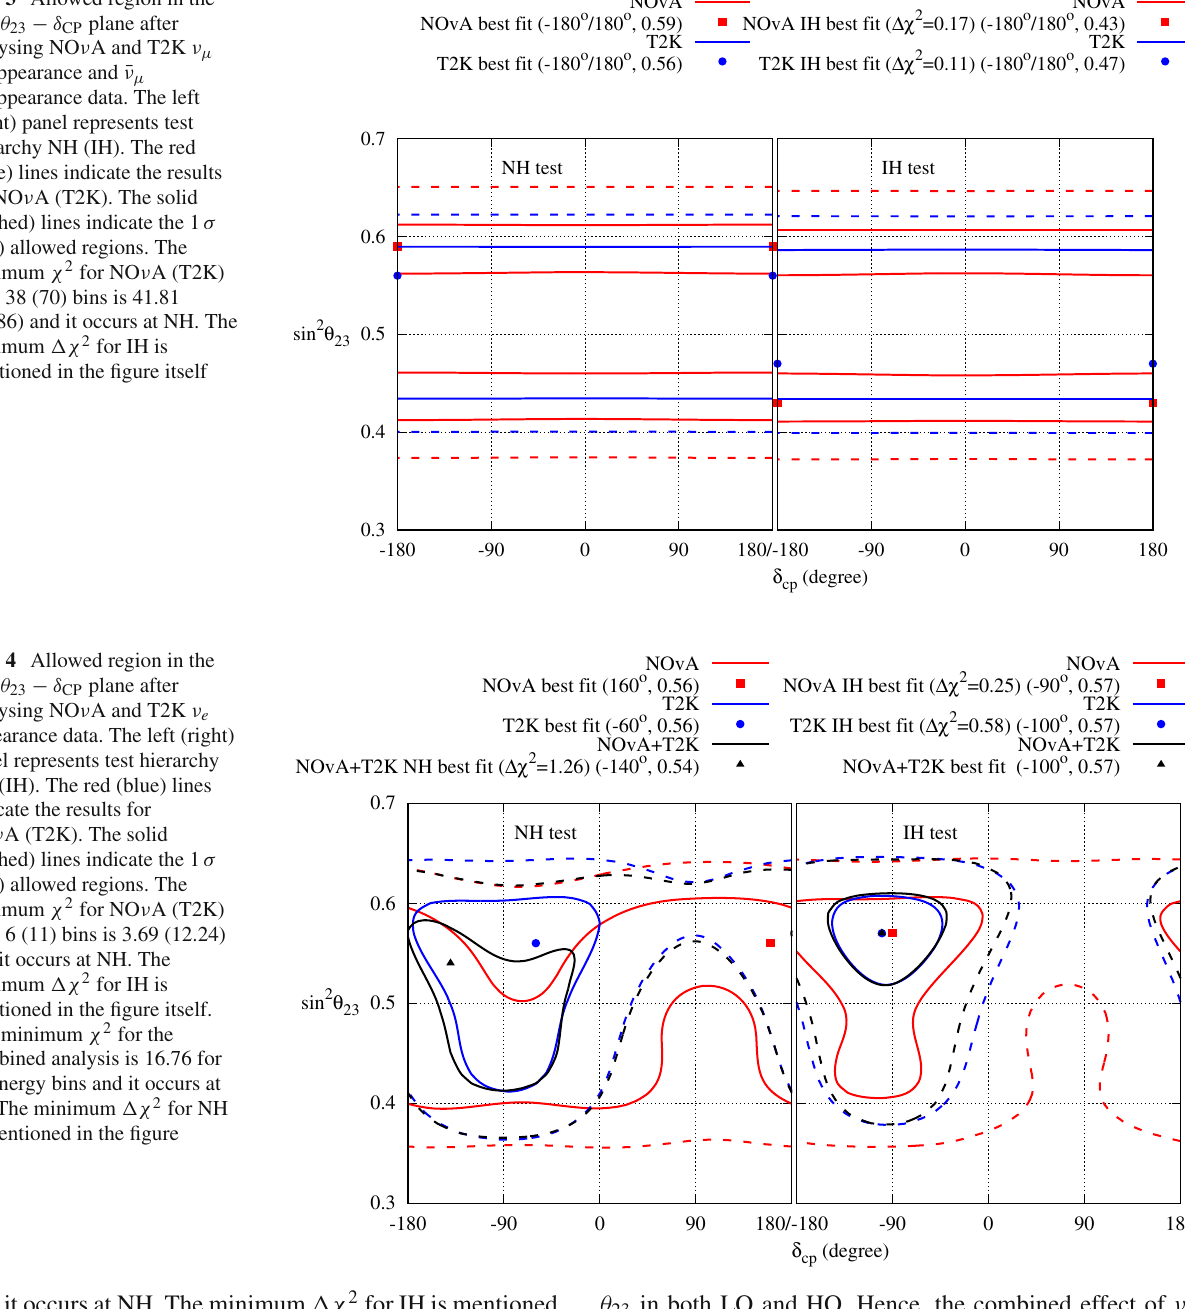
Fig. 4 Allowed region in the sin 2 θ 23 − δ CP plane after analysing NO ν A and T2K ν e appearance data. The left (right) panel represents test hierarchy NH (IH). The red (blue) lines indicate the results for NO ν A (T2K). The solid (dashed) lines indicate the 1 σ (3 σ ) allowed regions. The minimum χ 2 for NO ν A (T2K) with 6 (11) bins is 3.69 (12.24) and it occurs at NH. The minimum (cid:5)χ 2 for IH